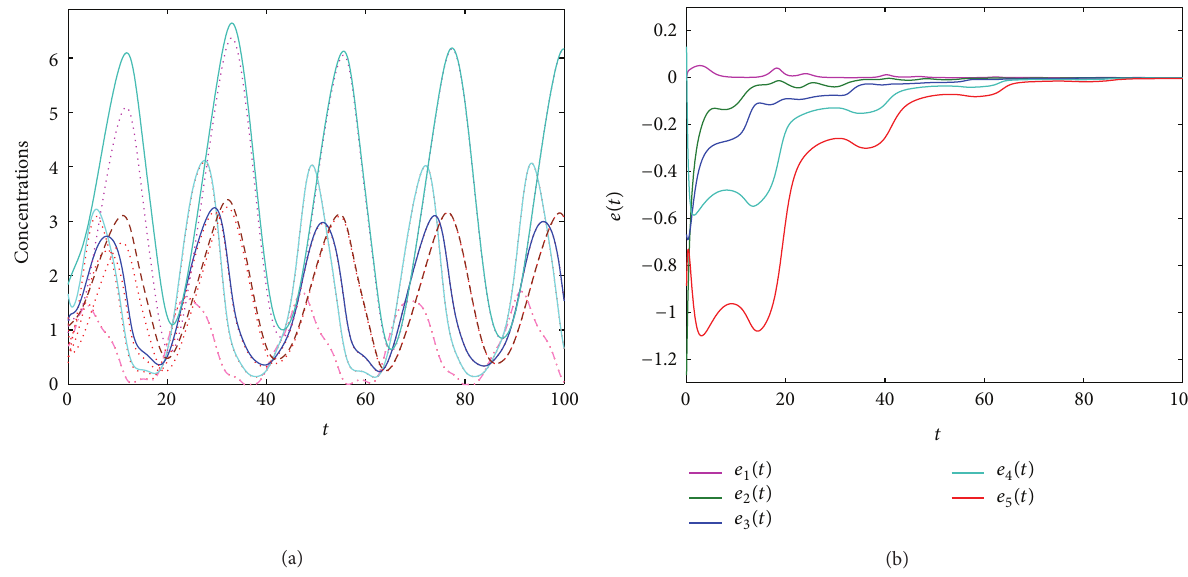
Figure 3: (a) State trajectories of systems (3) and (8) with 𝑢(𝑡) = 𝜖 sin (𝑡) . (b) The error dynamics of system (11). Here, 𝑦(𝑡) = 𝑐𝑥 1 (𝑡), 𝑘 = 2.5, 𝑐 = 2, and 𝜖 = 0.1 .